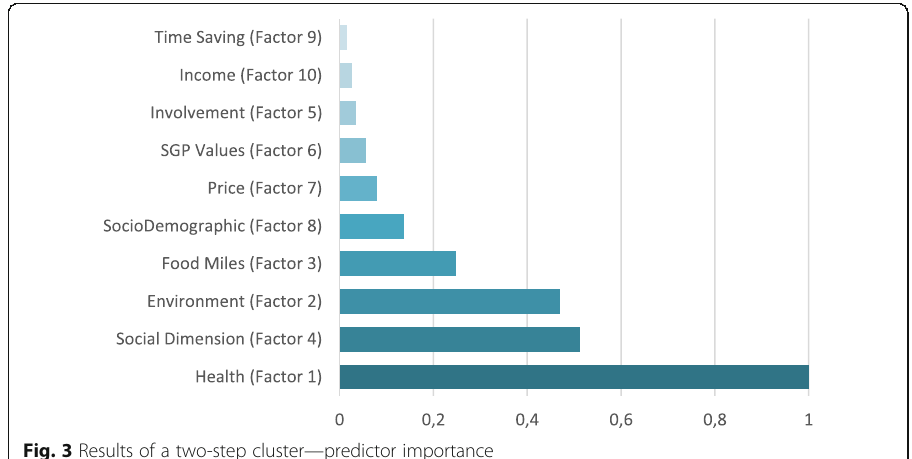
Fig. 3 Results of a two-step cluster — predictor